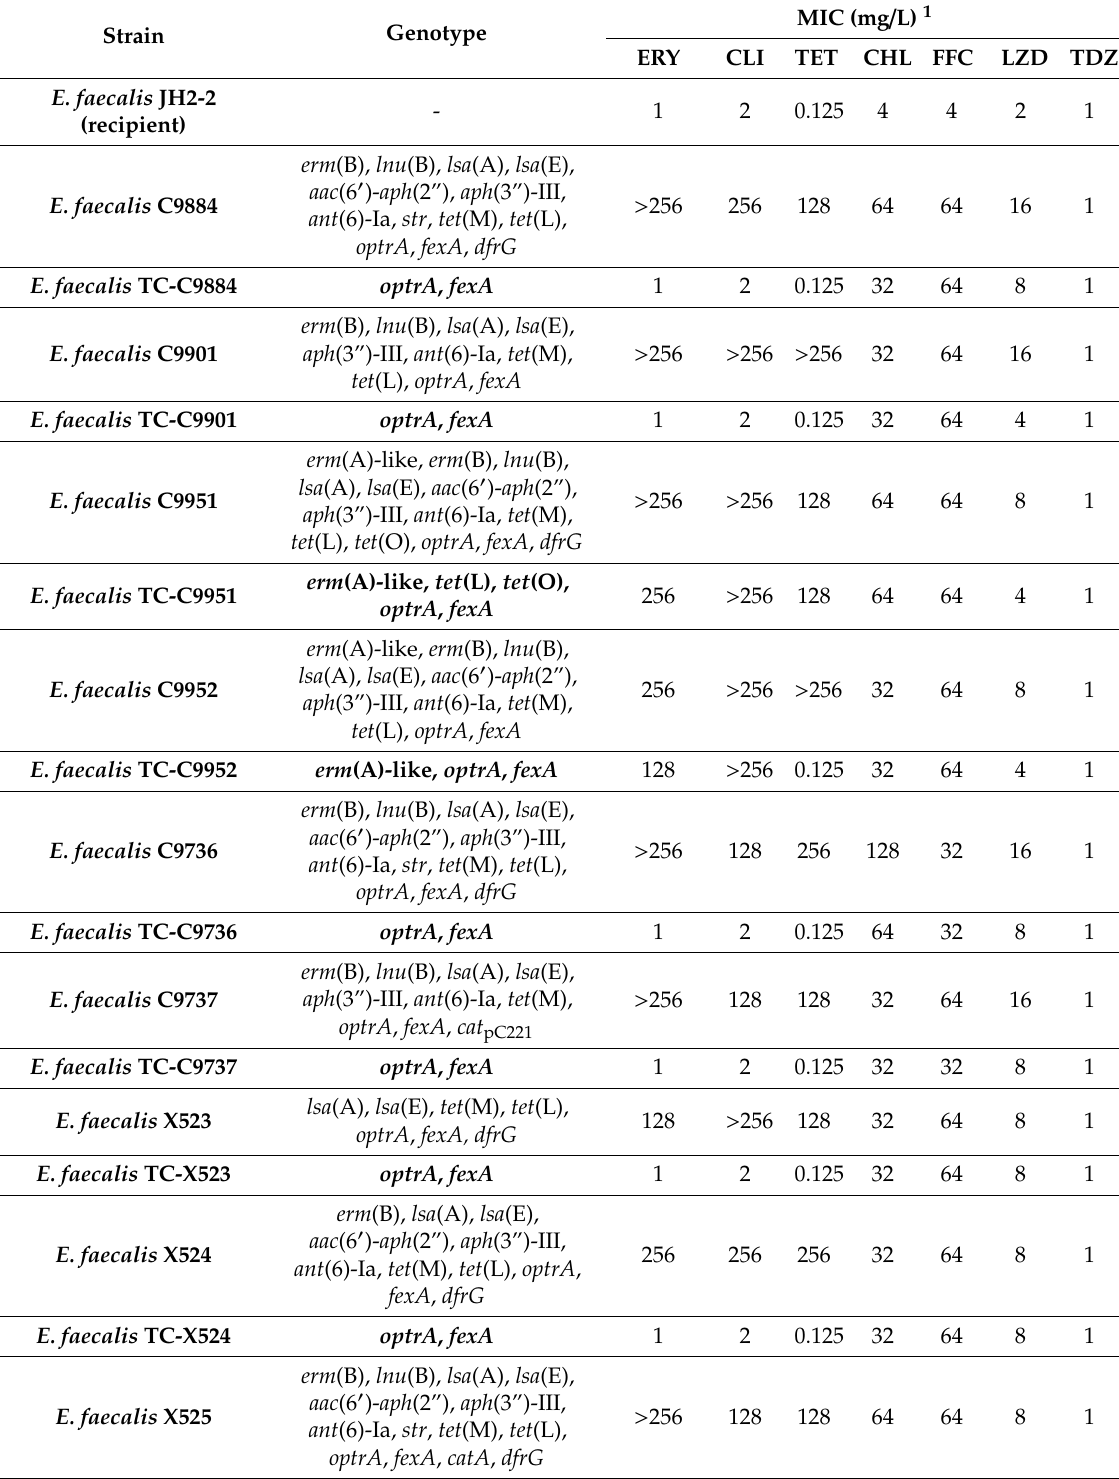
Table 3. Minimum inhibitory concentrations (MICs) of the recipient E. faecalis JH2-2, the E. faecalis donor strains, and the respective